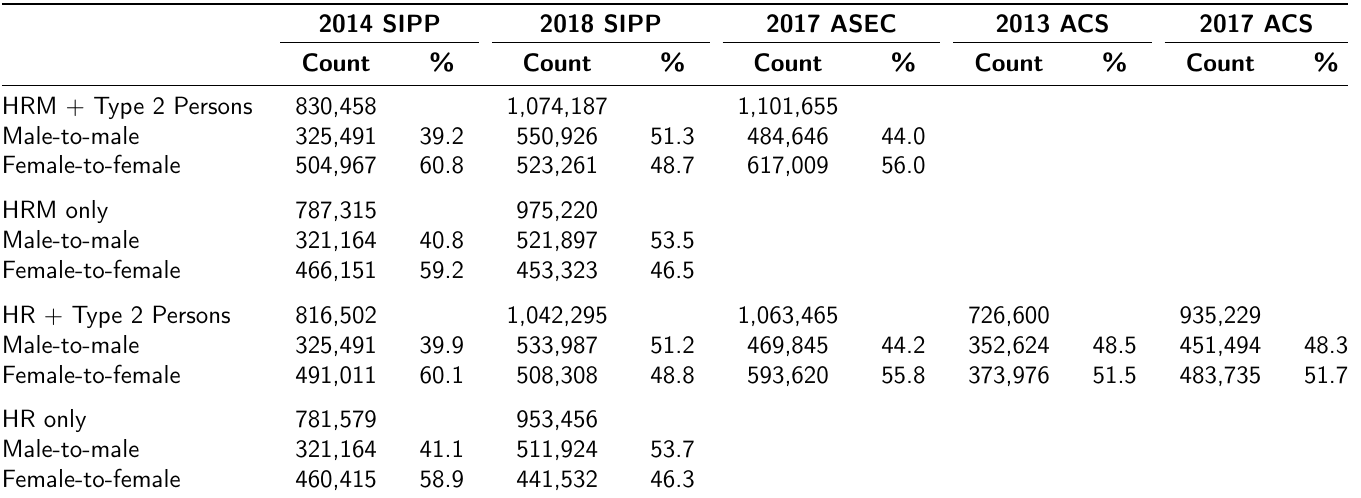
Table 3: Estimated counts of households with same-sex couples, by counting method and